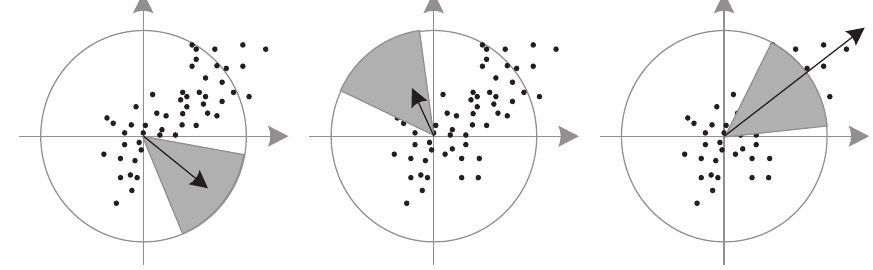
Figure 3: Main direction selection.